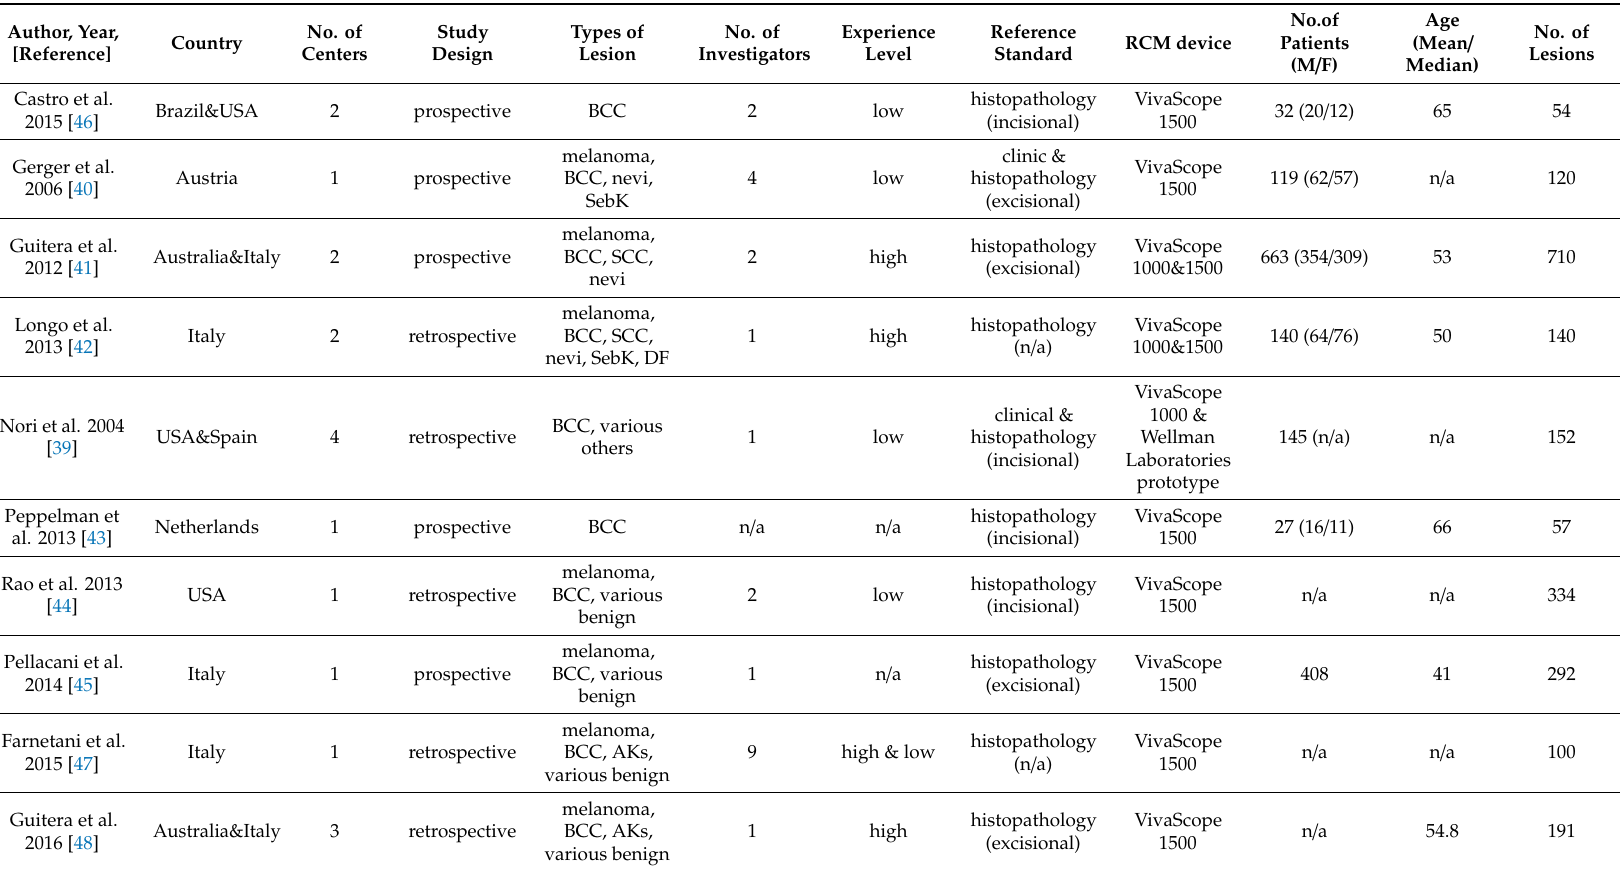
Table 1. Characteristics of included